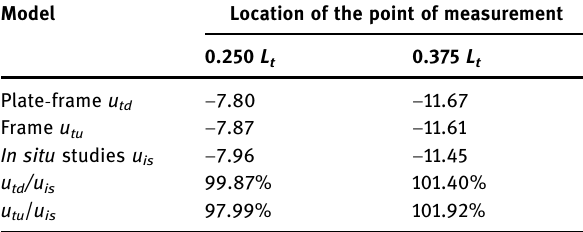
Table 3: Comparison of the vertical de fl ections of the bridge span resulting from its static loading obtained in the studies of the physical structure and numerical studies